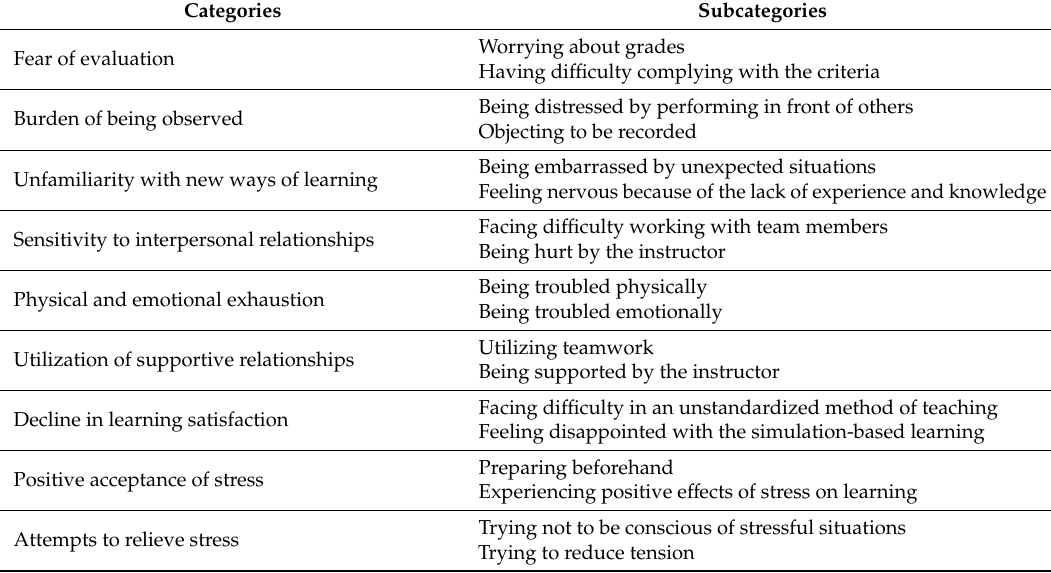
Table 2. Content analysis: nursing students’ experiences of stress in simulation-based